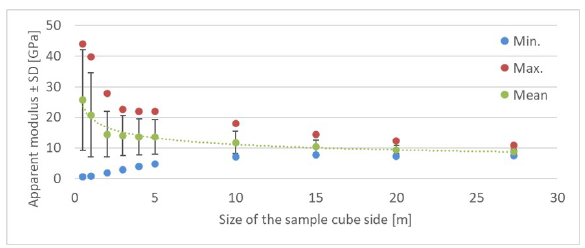
Figure 4. Apparent deformation moduli – z axis.